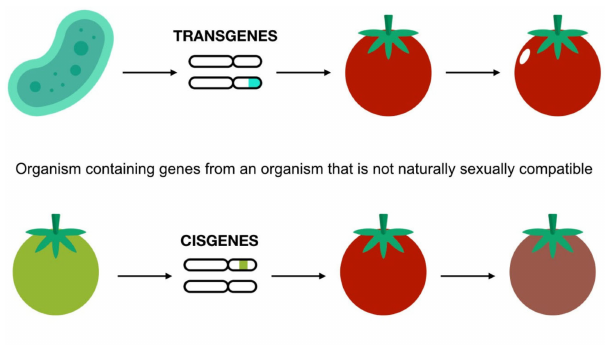
Figure 4. Cisgenic and transgenic modification. Icons made by Freepik and Smashicons from www.flaticon.com (accessed on 1 December 2021). Adapted from